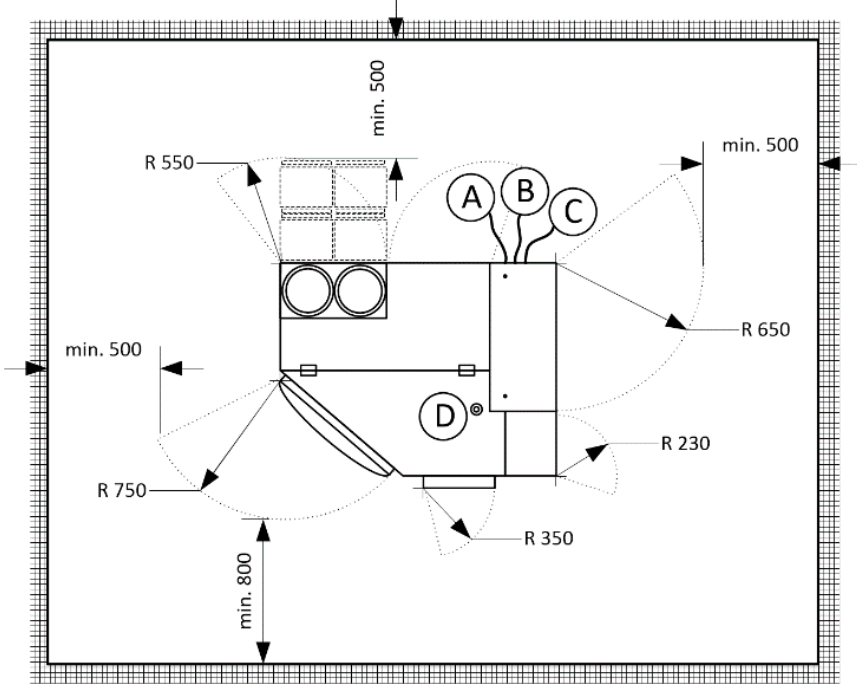
Figure 2. Requirements regarding space and location of connections for an exemplary SLS device [34].